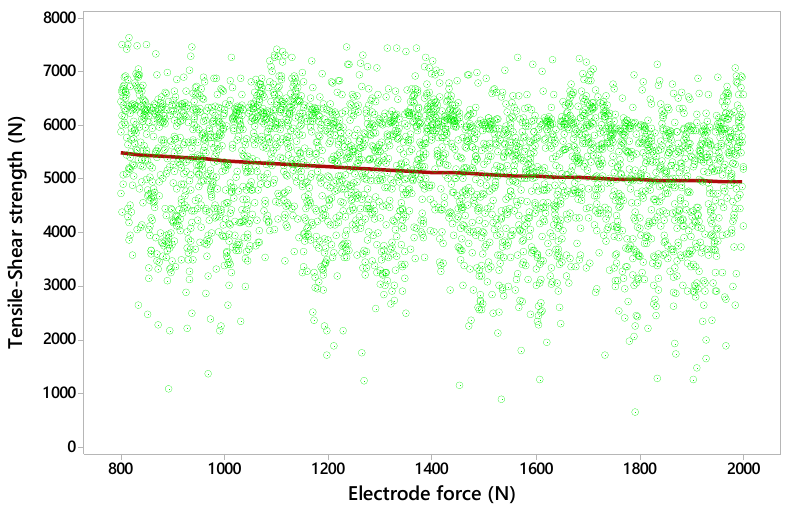
Figure 14. Effect of electrode force on TSS of spot welds.